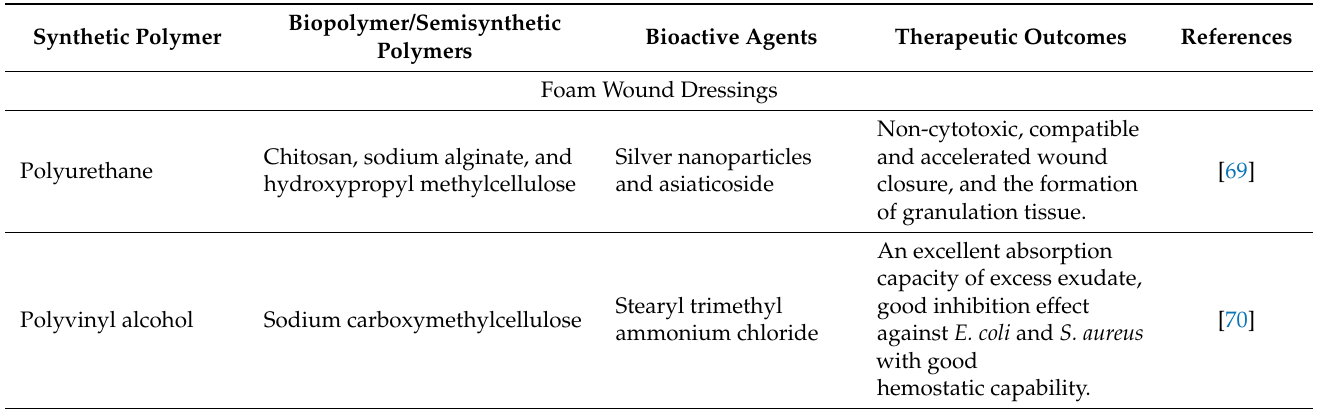
Table 1. A summary of hybrid-polymer-based wound